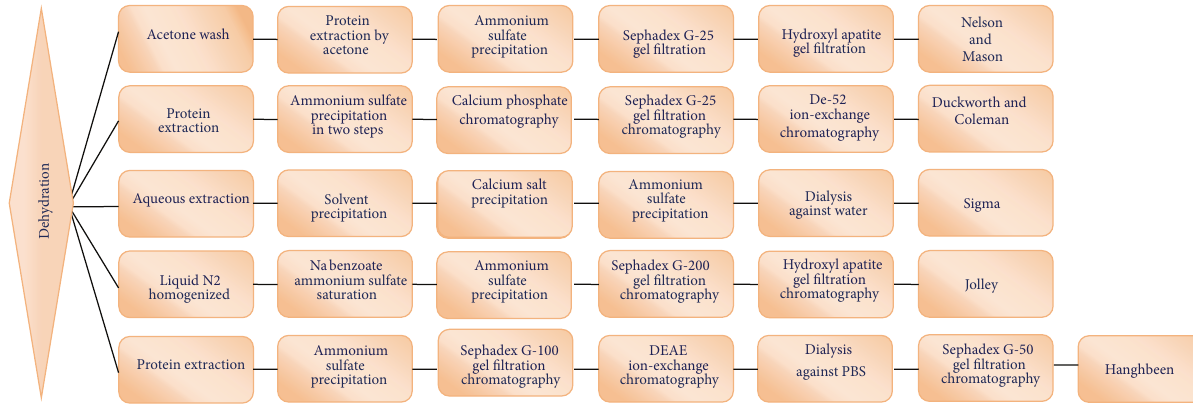
Figure 2: Purification scheme of